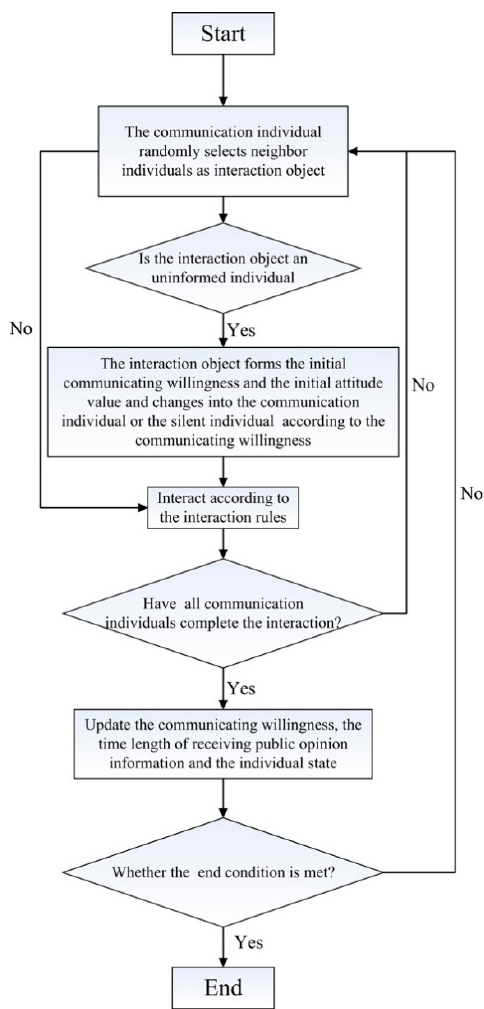
Figure 5. The evolution of public opinion.